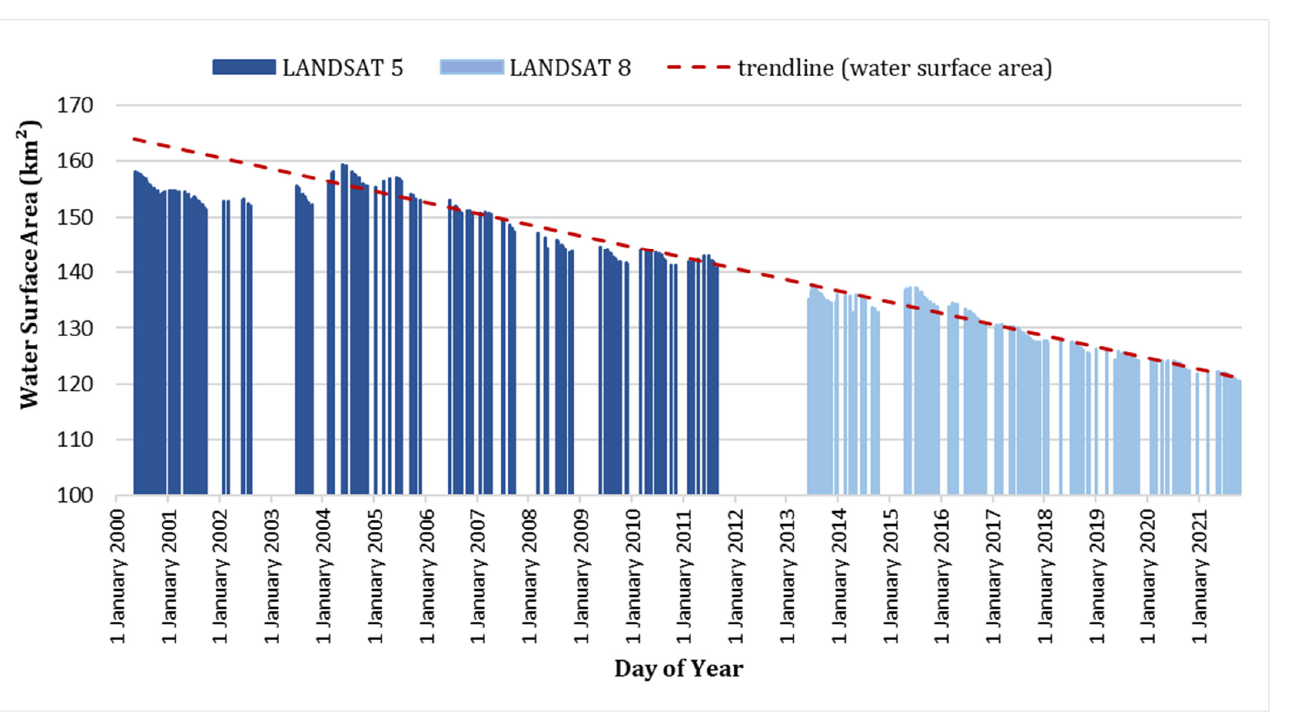
Figure 5. Water surface area temporal changes and trendline for Lake Burdur between 2000 and